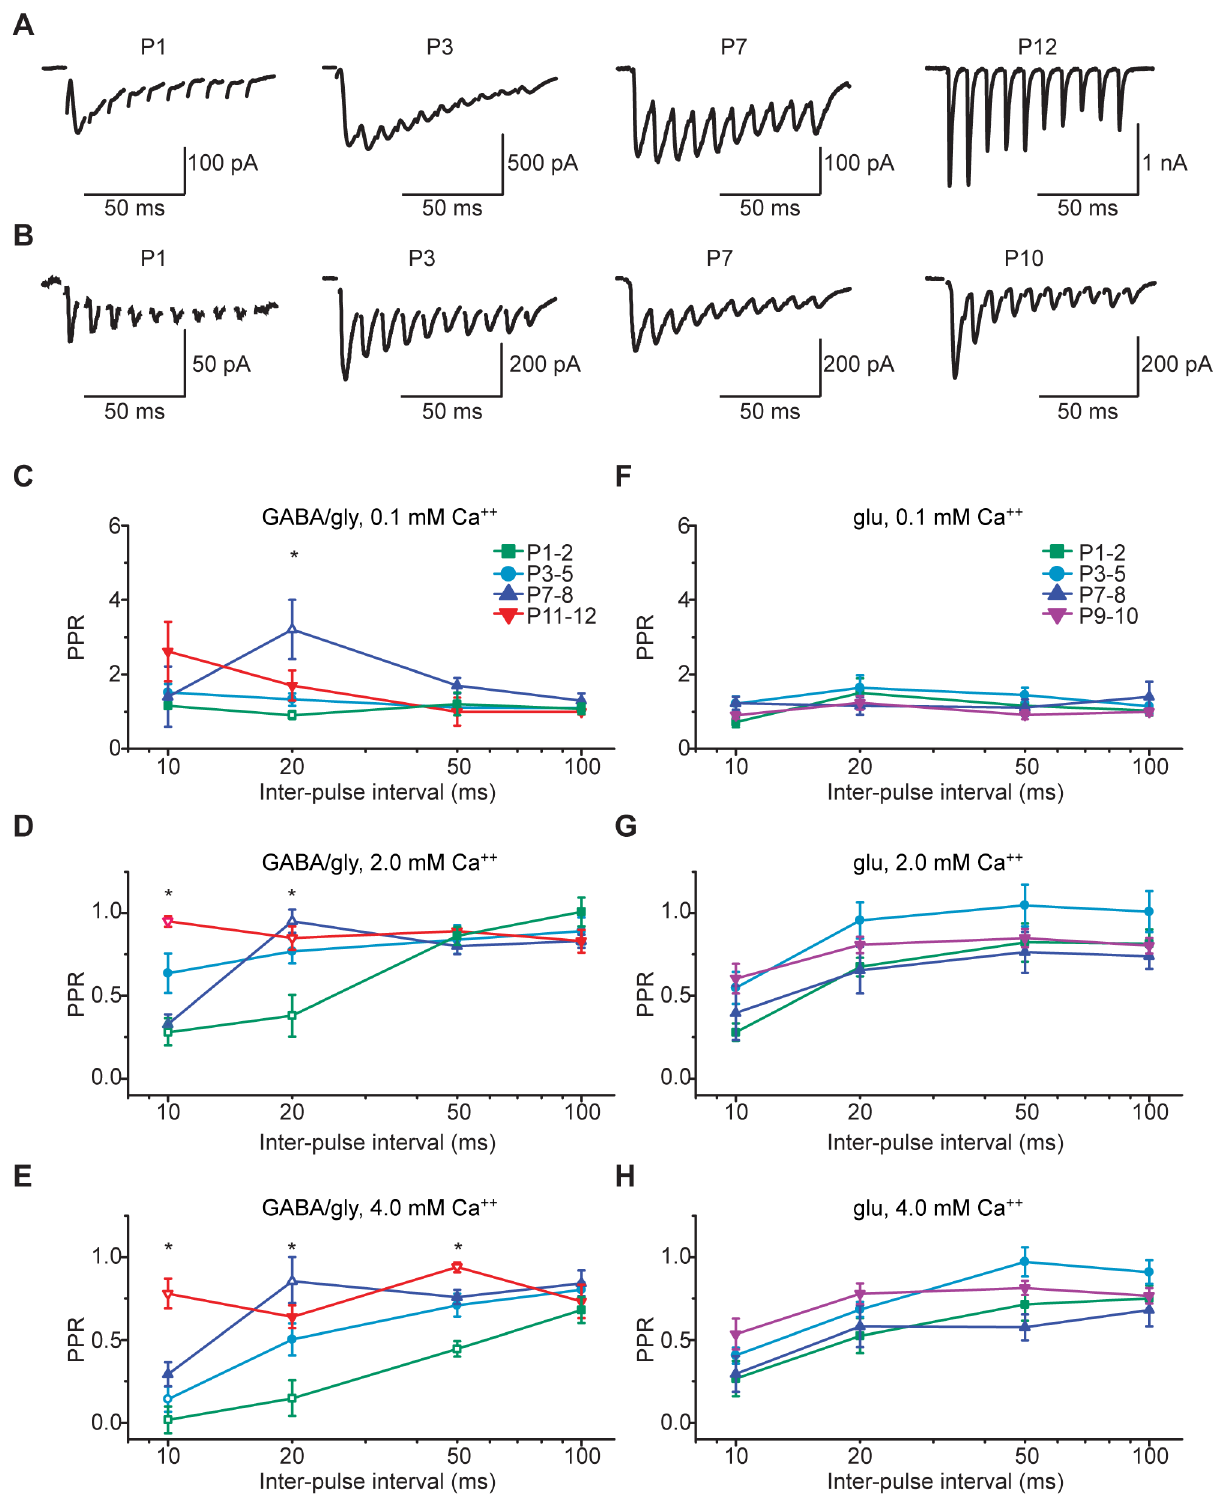
Figure 2. Paired-pulse properties of GABA/gly, but not glutamate, component are significantly altered by developmental age. A ) Representative GABA/glycine-mediated PSCs (average of 10 traces) recorded in the presence of CNQX (5 m M). B ) Glutamate-mediated PSCs (average of 10 traces) recorded in the presence of picrotoxin (50 m M), strychnine (10 m M), and cyclothiazide (100 m M). All recordings, in response to 100 Hz electrical stimulation in the MNTB, at a holding potential of 2 70 mV, with an external Ca ++ concentration of 2 mM. C–E ) Summary of PPRs at inter- pulse intervals of 10, 20, 50, and 100 ms for the GABA/gly component in ( C ) 0.1 mM ( D ) 2.0 mM, and ( E ) 4.0 mM external Ca ++ . * P , 0.05 (Kruskal- Wallis test; Dunn’s post hoc). F–H ) Summary of PPRs for glutamate component at 10, 20, 50, and 100 ms inter-pulse intervals in ( F ) 0.1 mM, ( G ) 2.0 mM, and ( H ) 4.0 mM external Ca ++ . Open symbols in C–E indicate which groups showed significant differences. doi:10.1371/journal.pone.0075688.g002 PLOS ONE | www.plosone.org